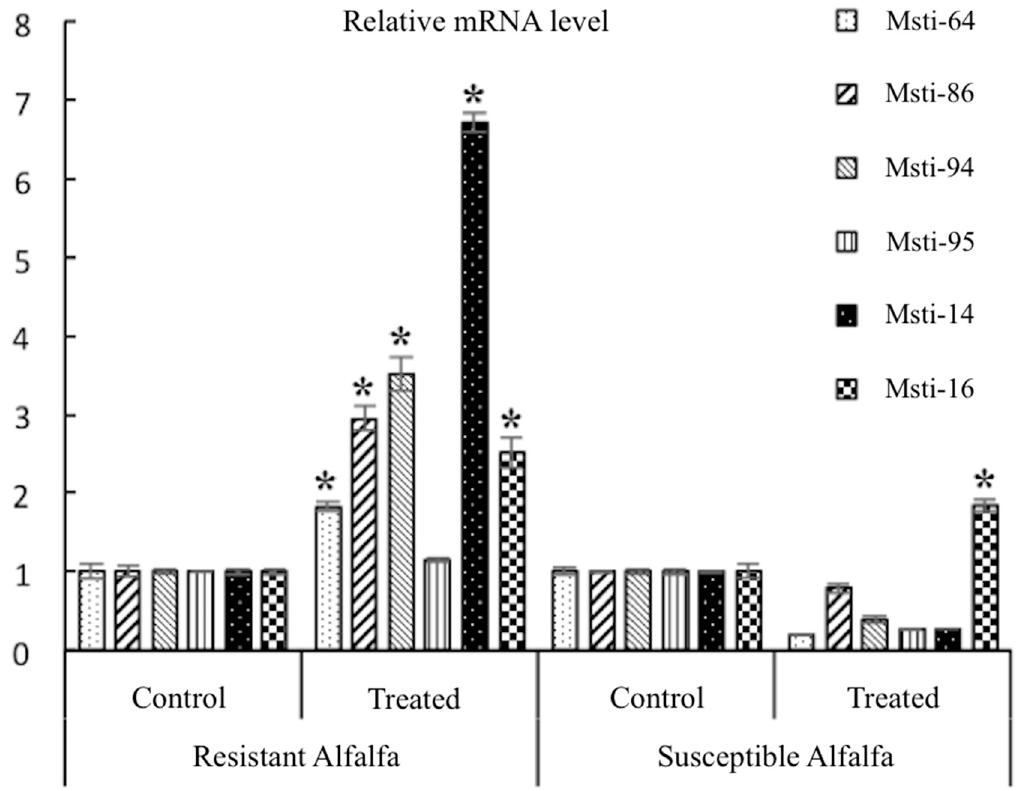
Figure 2. Relative expression of the six selected differentially expressed genes (DEGs), where control refers to treatments without aphids after 72 h, and treated refers to treatments with 30 aphids feeding after 72 h on resistant (cv. Zhongmu-1) or susceptible (WL323) alfalfa cultivars; * significant at a 5% level of probability using SPSS 20.0 with the Duncan multiple range test.